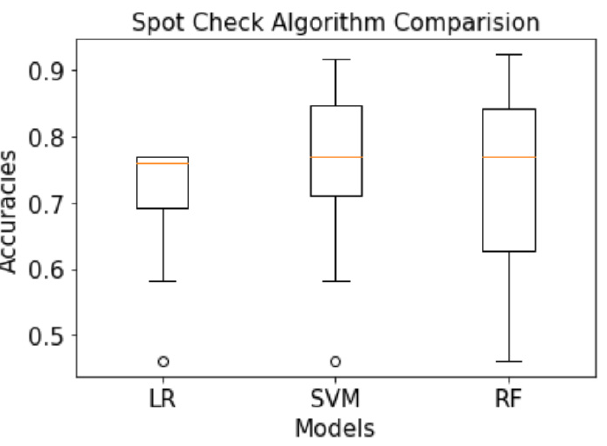
Figure 6. Spot Check Algorithm comparison for Logistic Regression, SVM and Random Forest mod- els.